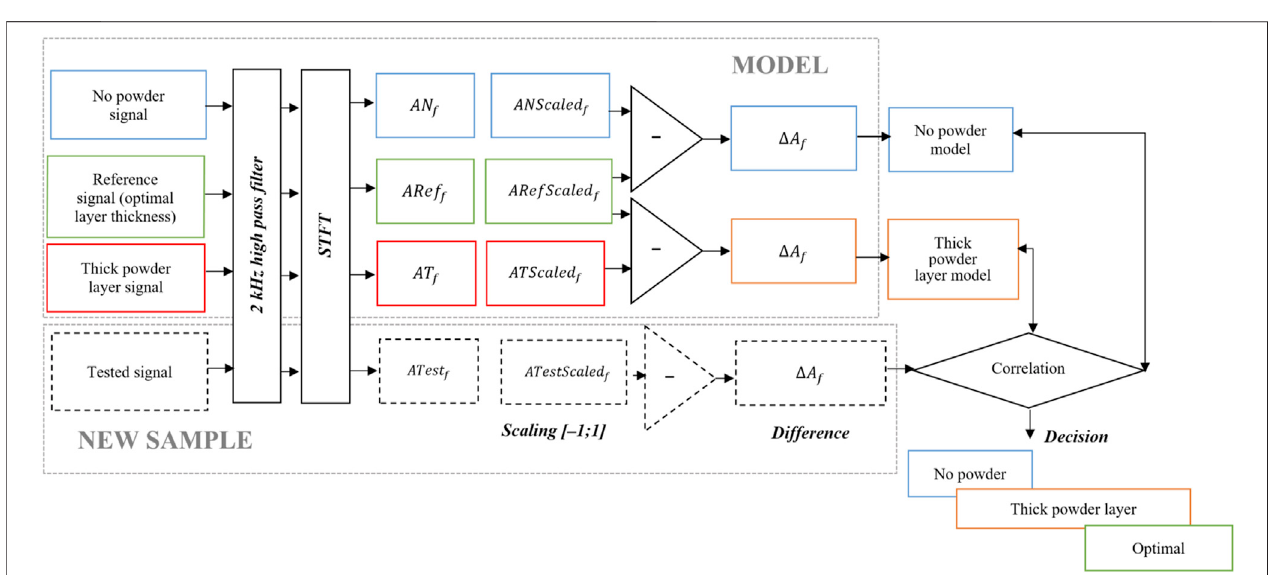
FIGURE 10 | Flowchart for recognition of layer thickness by AE signals.